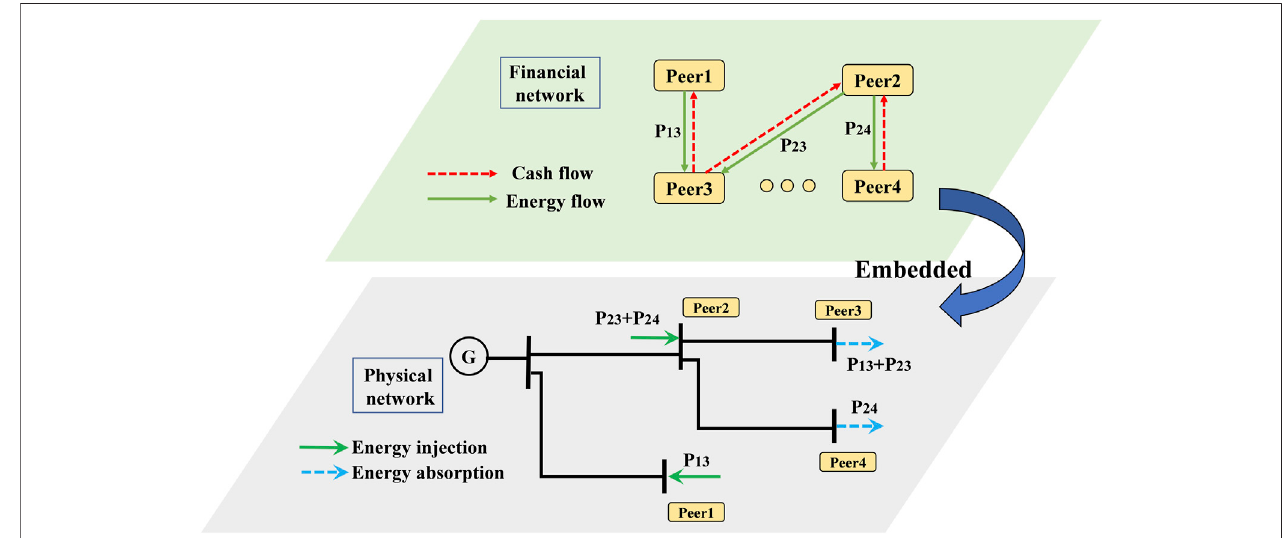
FIGURE 4 | P2P transaction embedded in physical network.